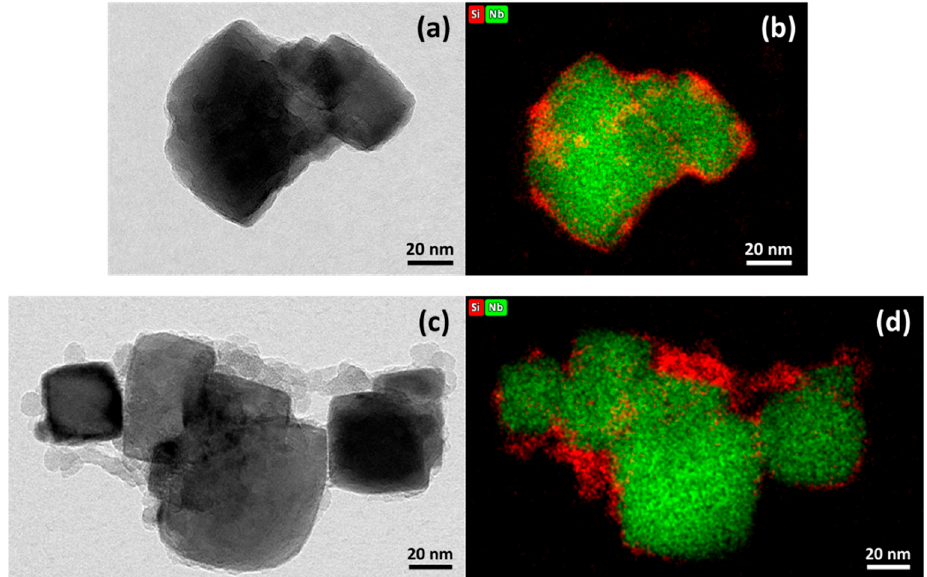
Figure 2. Representative STEM images of LNO@COOH and LNO@N 3 NPs: ( a ) bright field and ( b ) EDX elemental mapping (Si and Nb) of LNO@COOH ; ( c ) bright field and ( d ) EDX elemental mapping (Si and Nb) of LNO@N 3 .